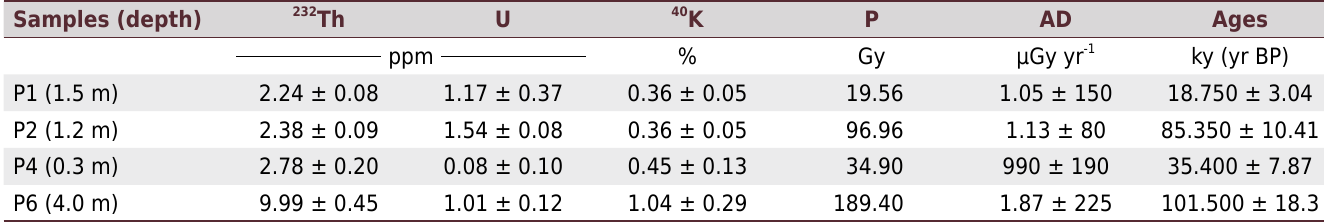
Table 1. Ages of the Post-Barreiras sediments obtained by optically stimulated luminescence (OSL) dating Samples